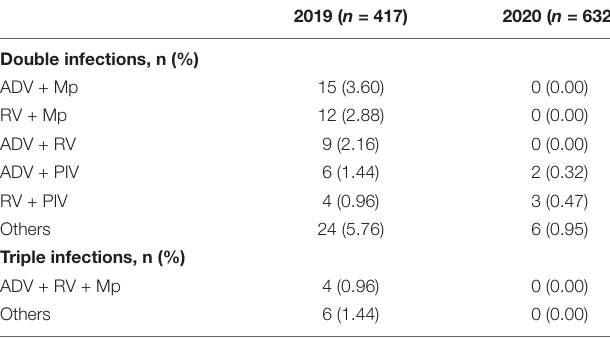
TABLE 2 | Co-infections of respiratory pathogens in hospitalized patients with lower respiratory tract infections (LRTIs) during the year of 2020 (February 2020